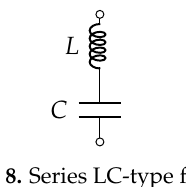
Figure 7. C-type filter.